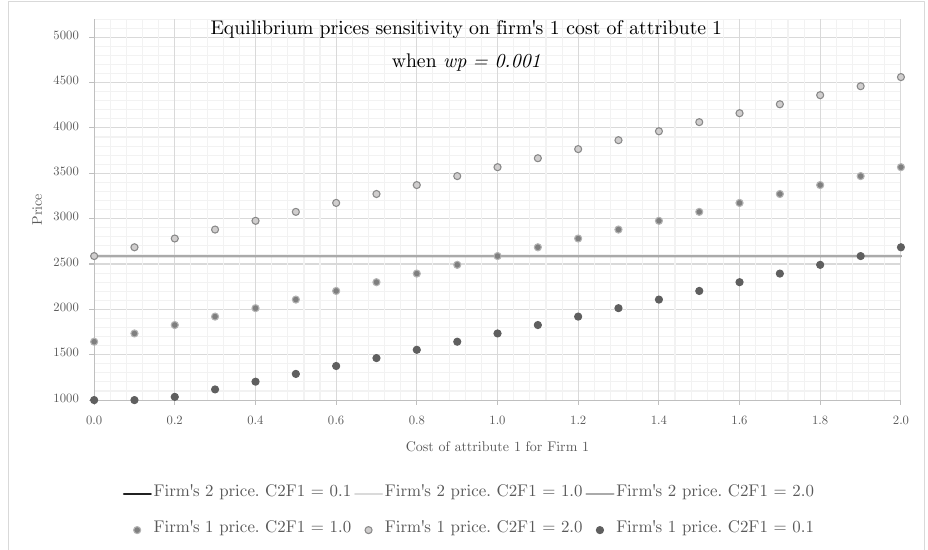
Figure A3. Price for firms varying attributes’ costs of Firm 1 when wp ≈